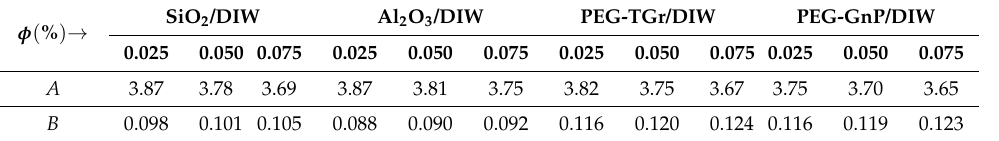
Table 8. The values of parameters A and B at different nanoparticle volume fractions.